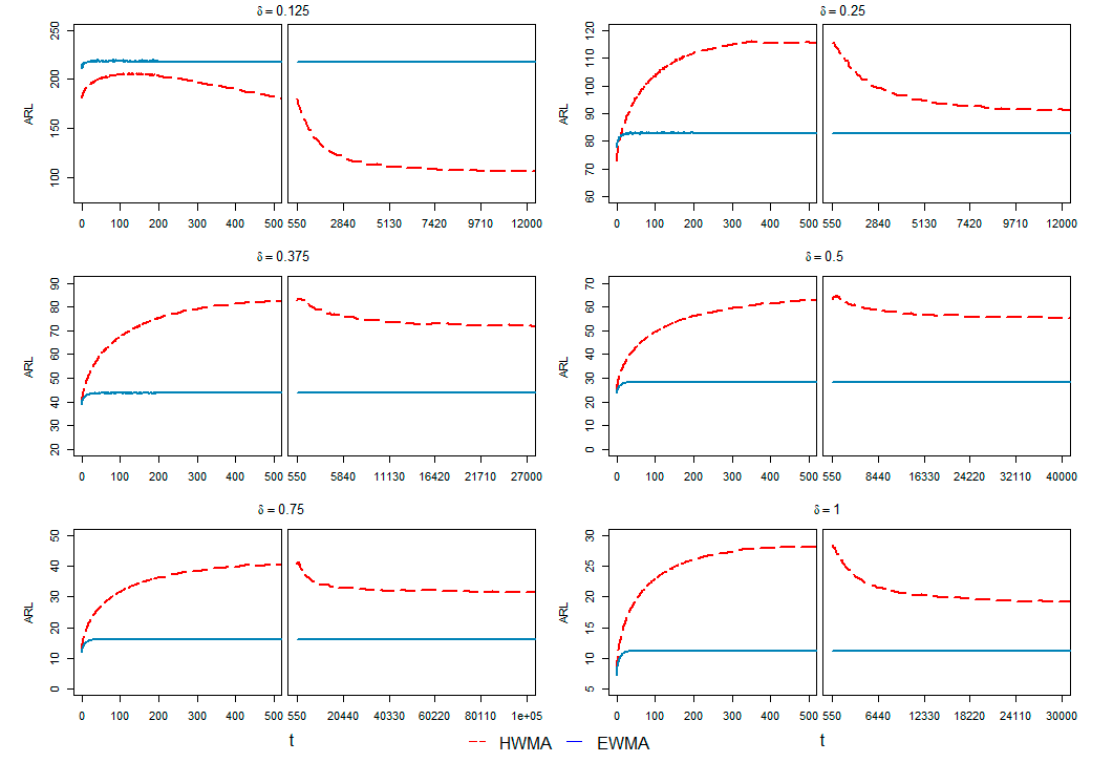
Figure 4. CED curves for the HWMA and EWMA charts under small to moderate shifts at 𝜆 = 0.05 with respect to time points (𝑡) .